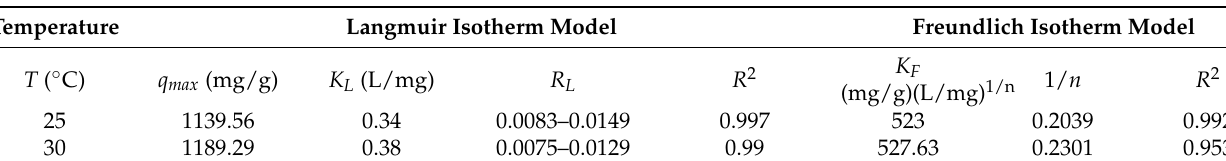
Table 4. Adsorption isotherm parameters of Langmuir and Freundlich models for the adsorption of sulfonated lignite by filter paper-templated Mg-Al metal oxides.